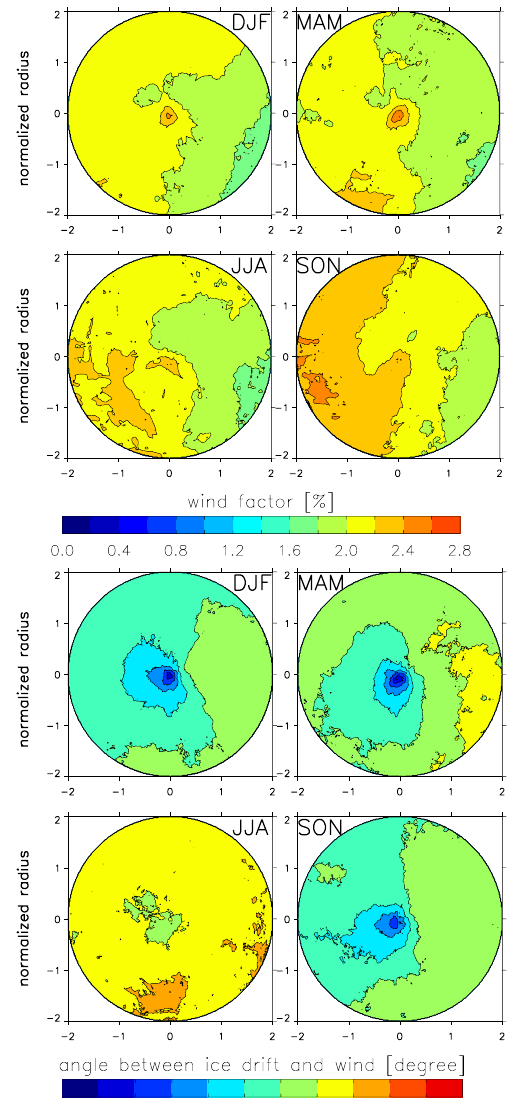
Fig. 10. Spatial distribution of the wind factor (top) and the angle between wind forcing and ice drift (bottom) for each season. Isoline interval is 0.2% for wind factor and 5 ◦ for deviation